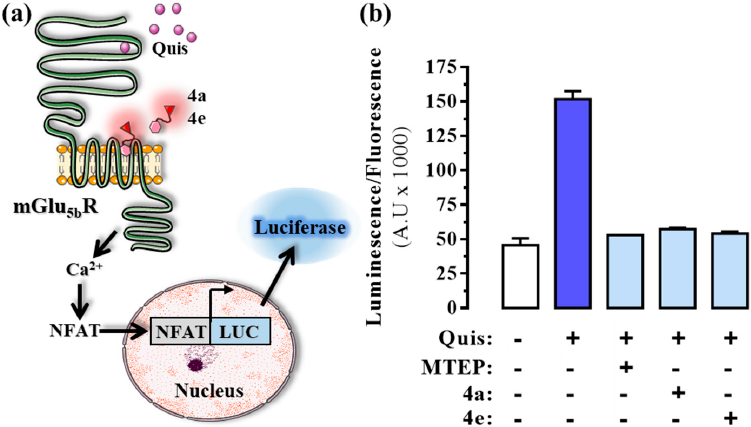
Figure 4. Evaluation of the mGlu 5b R constructs and ligand 4a in living cells. ( a ) Immunoblot detection of mGlu 5b R NL . Increasing amounts of membrane extracts (10 μ g, 30 μ g and 50 μ g of protein) from HEK293T cells transiently transfected with mGlu 5b R NL were analyzed by immunoblotting using a rabbit anti ‐ mGlu 5 R antibody (1 μ g/mL). Asterisk indicates the expected molecular weight (~150 kDa) of mGlu 5b R NL . ( b ) Luminescence detection of mGlu 5b R NL . HEK293T cells transiently transfected with mGlu 5b R NL were incubated with coelenterazine 400a for 5 min and luminescence recorded using a CLARIOStar plate reader. ( c ) The expression of mGlu 5b R SNAP was determined by assessing the fluorescence obtained after staining cells with the SNAP ‐ Surface 647 substrate. ( d ) Ligand ( 4a ) association to and diffusion in mGlu 5b R SNAP expressing cells as assessed by laser scanning confocal microscopy. The increase of the fluorescent signal was followed during 5 min. Scale bar: 100 μ m.